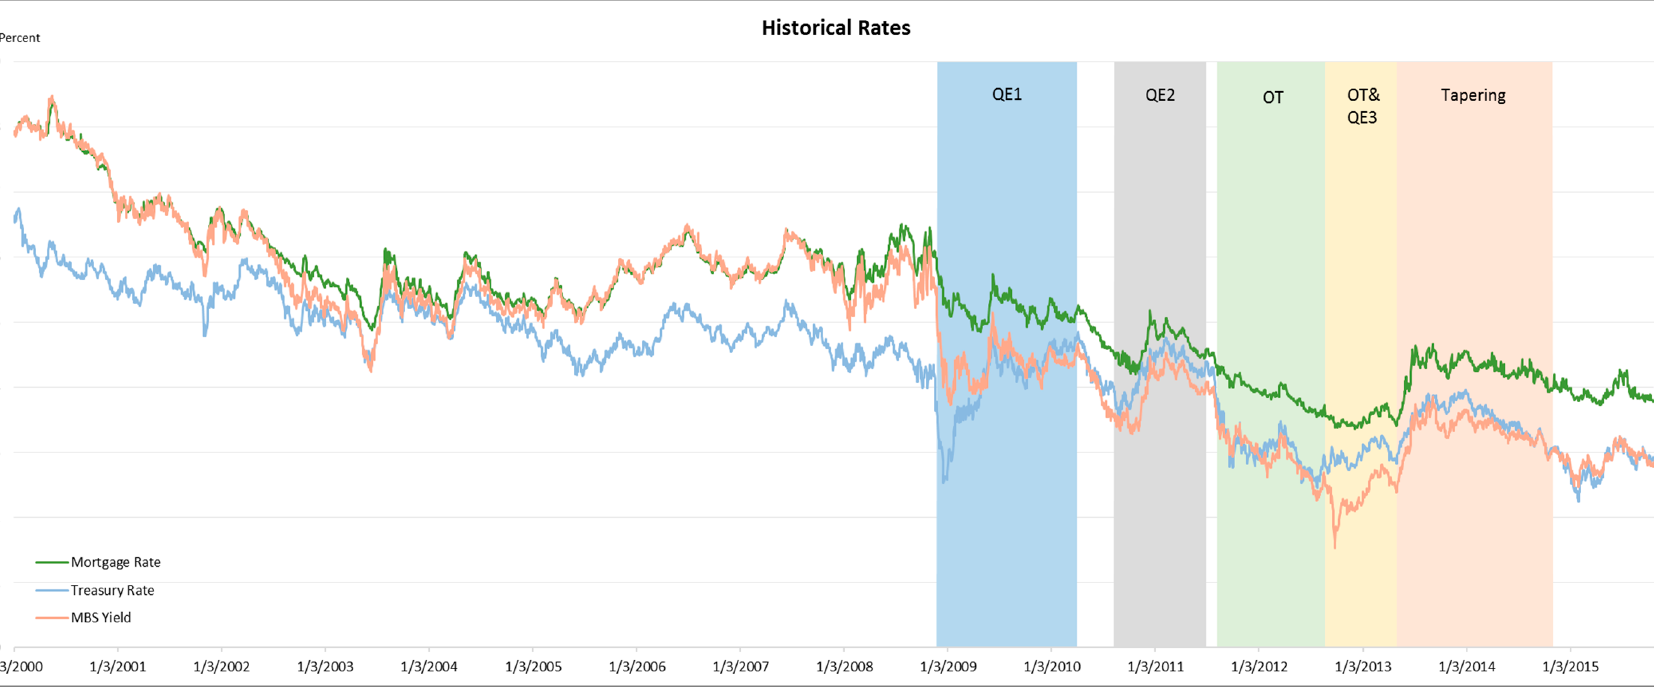
Figure 1. Mortgage rates, Treasury rates and mortgage-backed securities (MBS) yields. This figure shows time series of the 30-year mortgage rate, the 30-year Treasury rate and the 30-year Freddie Mac MBS current coupon yield from 3 January 2000 to 31 December 2015. The different rounds of quantitative easing (QE) are marked by different colors. Source: Bloomberg and U.S. Treasury.